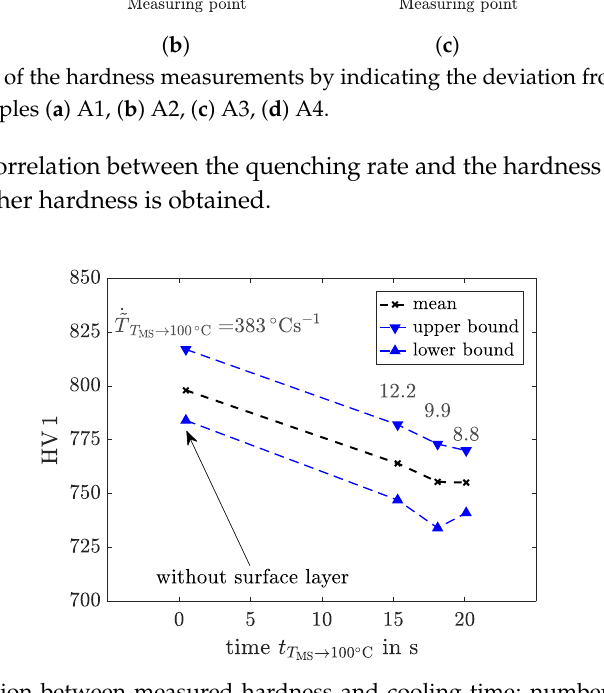
Figure 4. Correlation between measured hardness and cooling time; numbers above data points indicate cooling